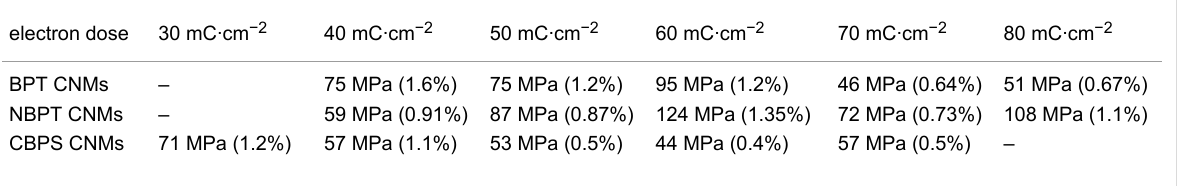
Table 1: Residual stress and strain of CNMs with different electron doses.